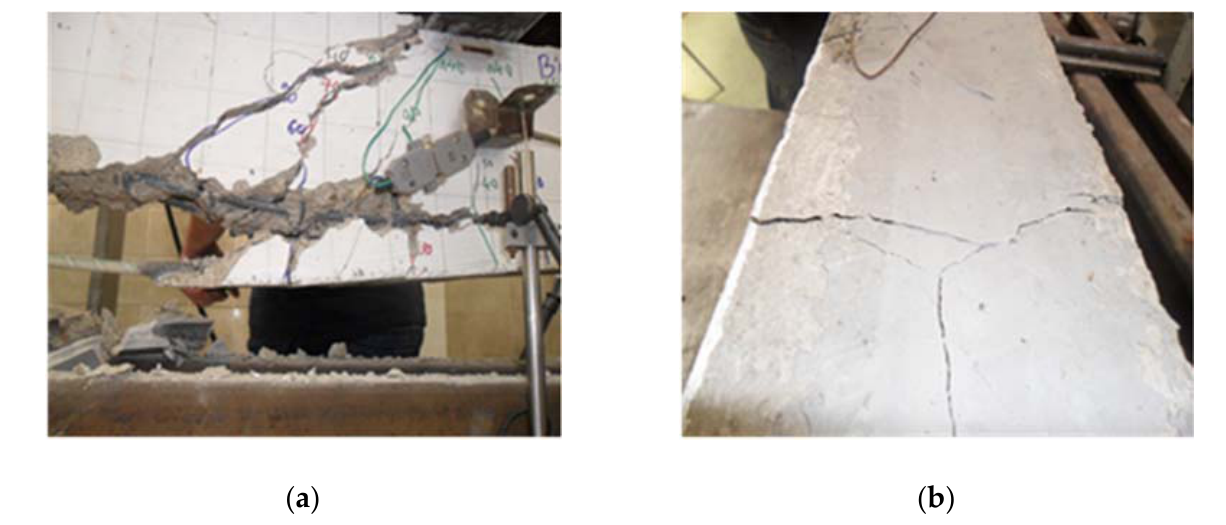
Figure 19. Beam B-G3: ( a ) Concrete separation at the level of protective layer of concrete; ( b ) Cracks in concrete on the top side of the beam intersecting the groove with the epoxy infill.